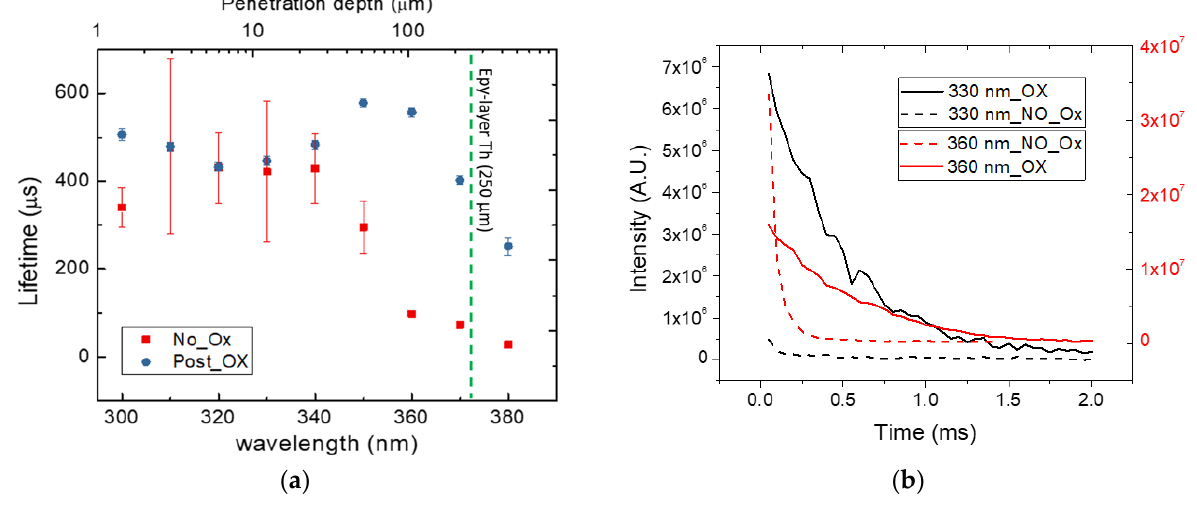
Figure 4. Time-resolved photoluminescence measurements at different source wavelengths in order to obtain information from different depths, before and after oxidation process ( a ), and the decay curve obtained by this measure at 330 and 360 nm for both samples ( b ).